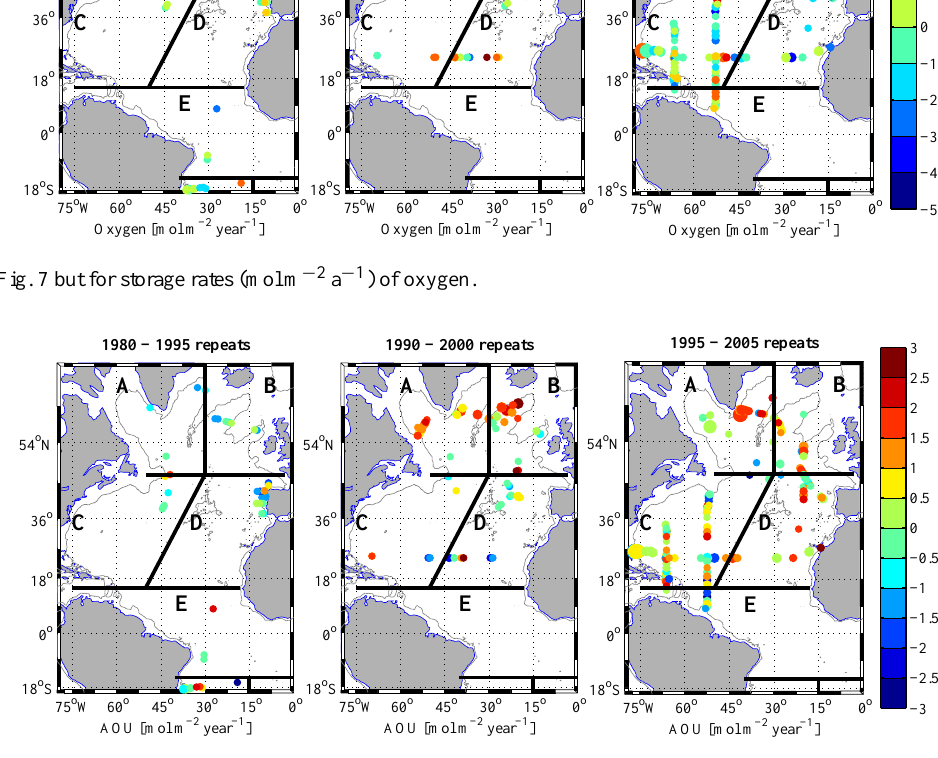
Fig. 10. Same as Fig. 7 but for storage rates (molm − 2 a − 1 ) of